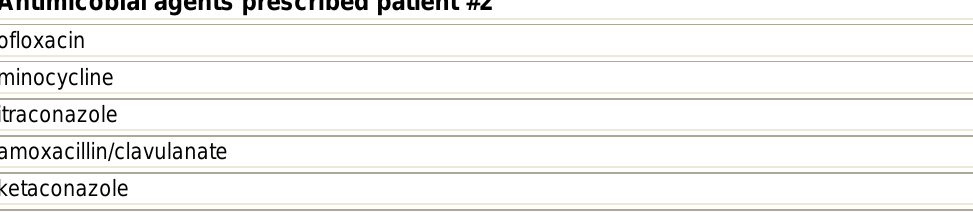
List of all antimicrobial agents prescribed for patient #2.